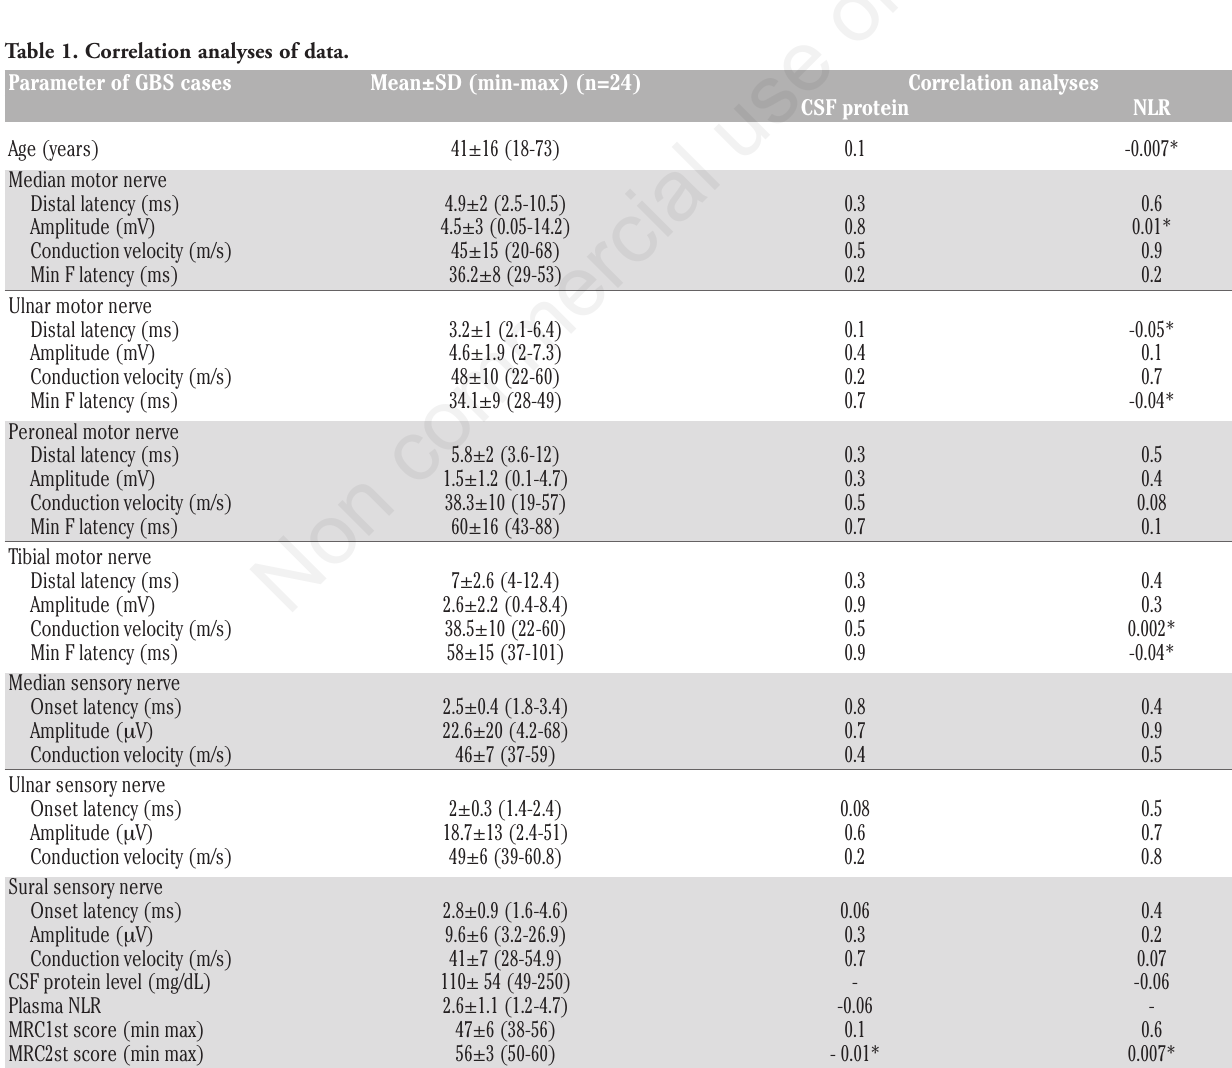
Table 1. Correlation analyses of data. Parameter of GBS